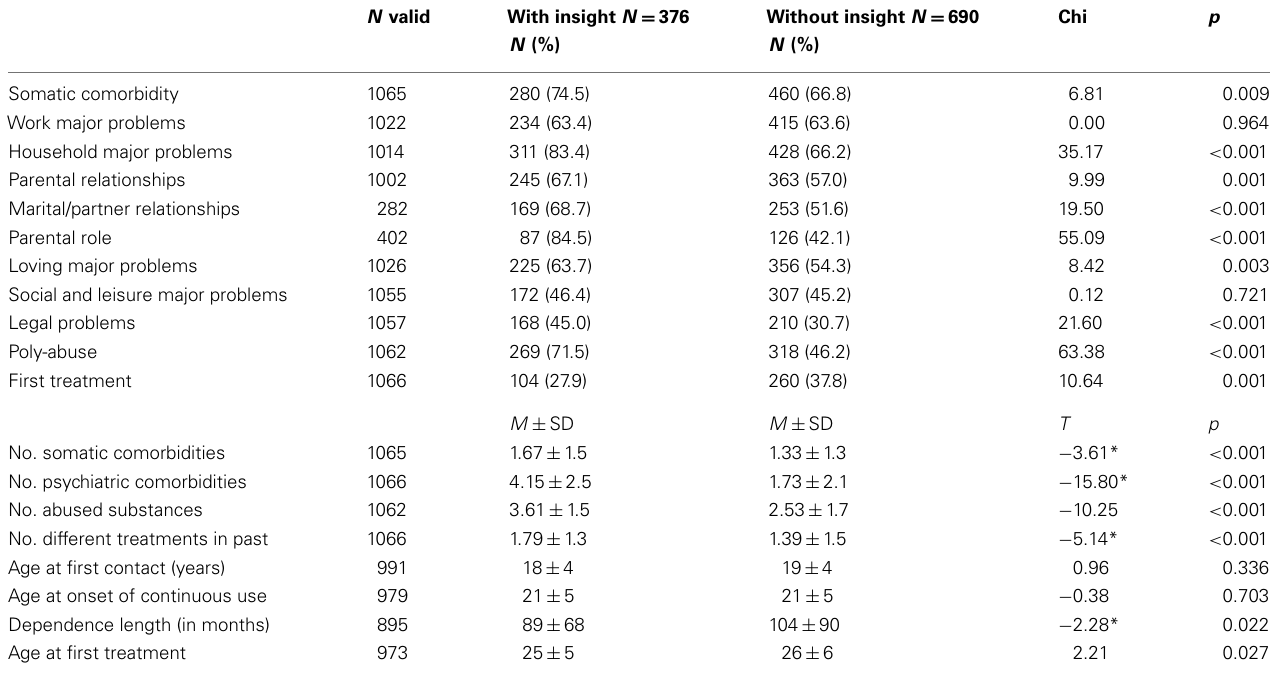
Table 1 | DAH-RS factors and addiction